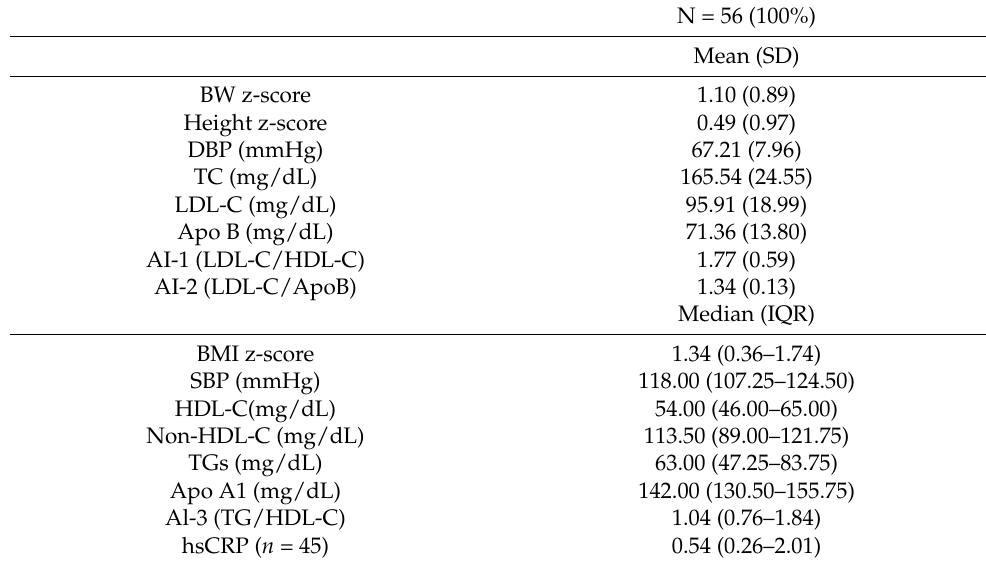
Table 4. Population clinical and laboratory